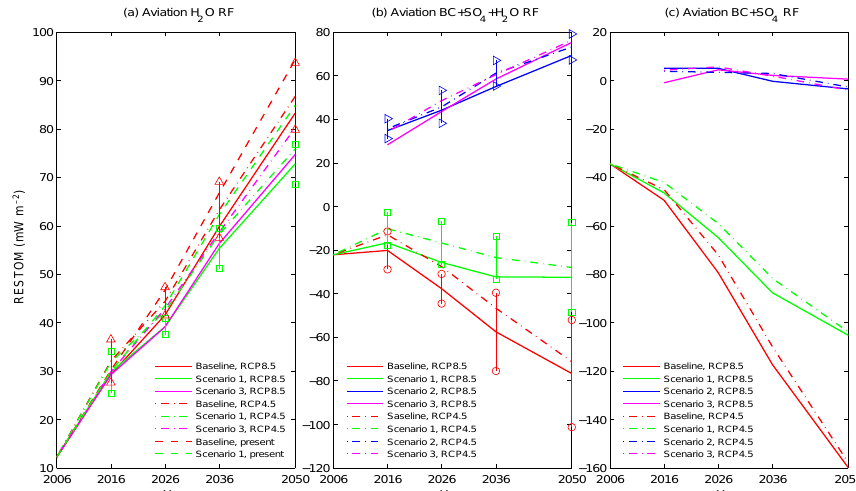
Figure 3. Time series of globally averaged radiative forcing in mWm − 2 based on various aviation emissions scenarios and background meteorologies due to (a) contrail cirrus only, (b) contrail cirrus and aviation aerosols and (c) aviation aerosols, deduced by the difference between panels (a) and (b) . RESTOM denotes the change in the net residual radiative flux at the top of model. Note that in panels (b) and (c) , there is no aviation sulfate aerosols in scenarios 2 and 3. Uncertainties plotted are based on 2 standard deviations of the four-member ensemble of background